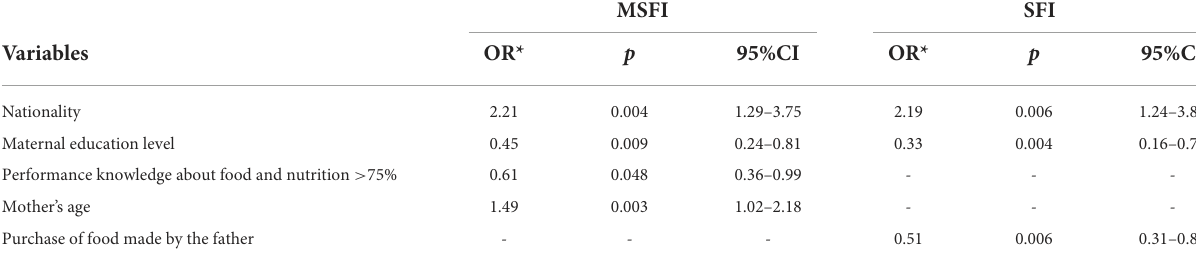
TABLE 5 Association between characterization variables of the group studied and the risk of presenting Moderate-Severe Food Insecurity (MSFI) and Severe Food Insecurity (SFI) in the household.